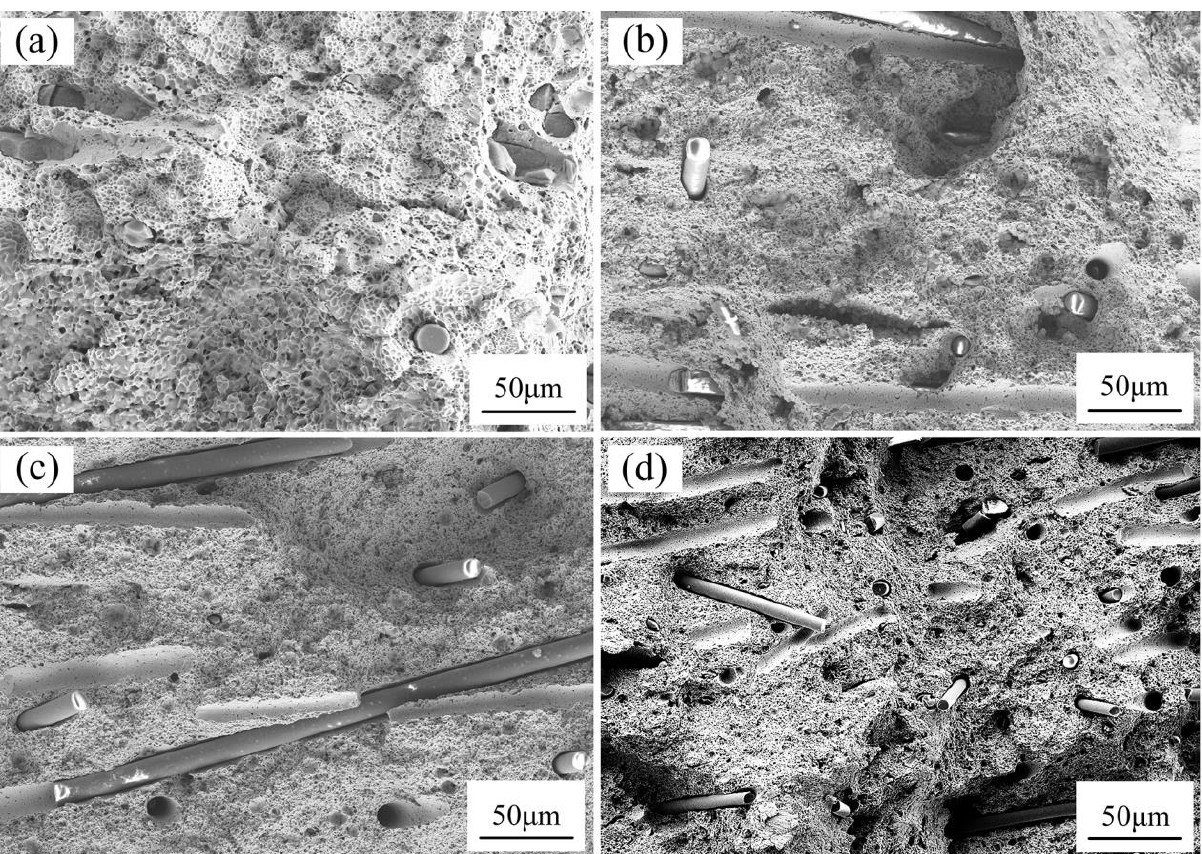
Figure 7. Fracture morphology of composites prepared at different basalt fiber contents: ( a ) 0.5 wt.%, ( b ) 1 wt.%, ( c ) 1.5 wt.%, ( d ) 2 wt.%.